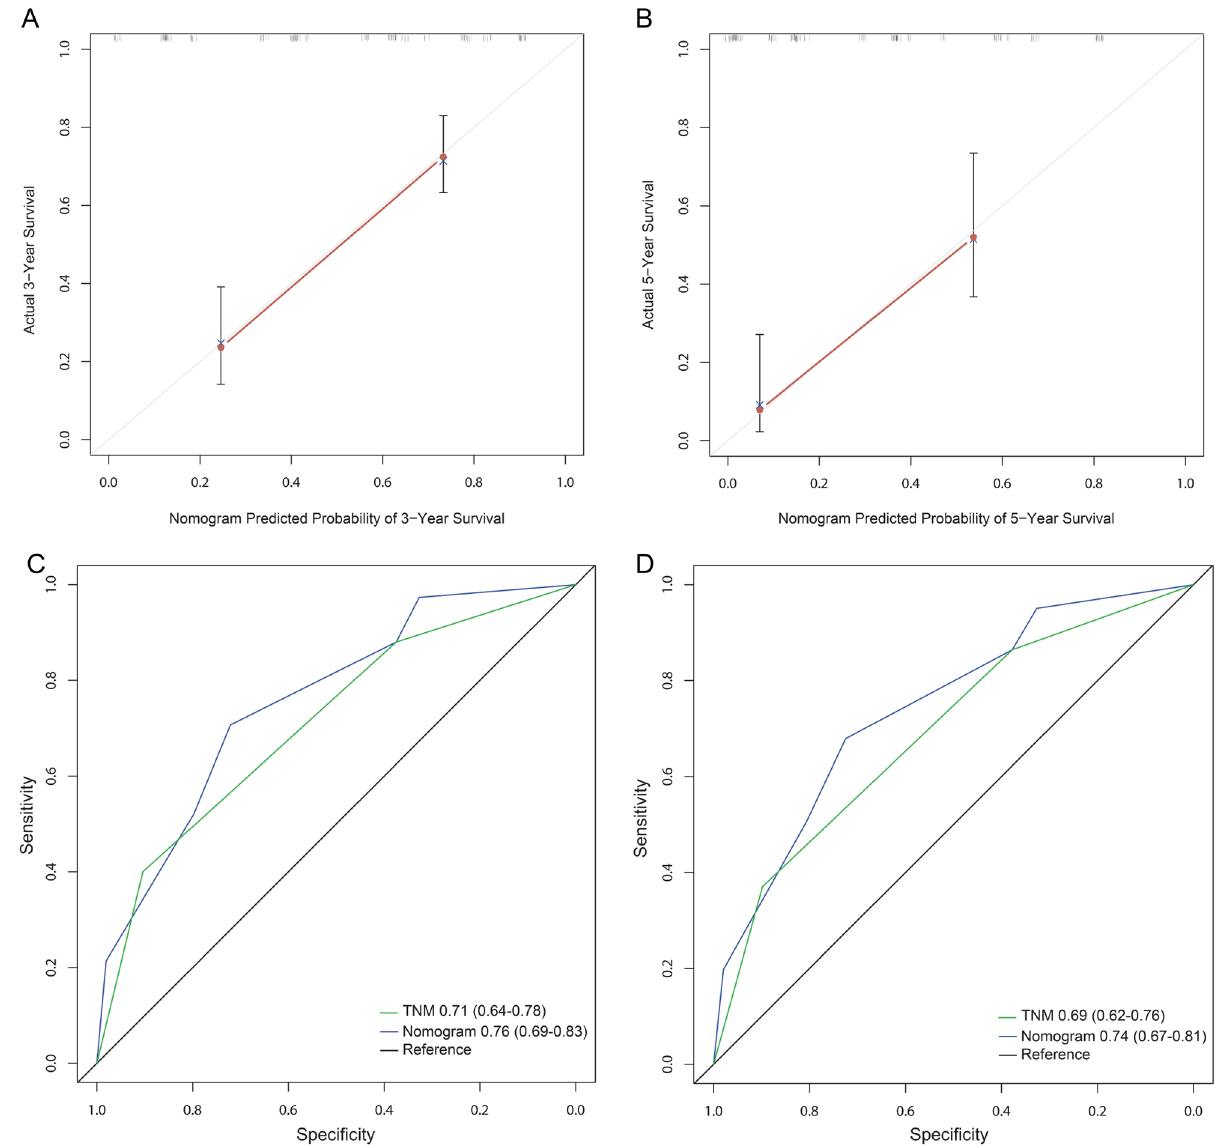
Figure 5. The 3-year ( A ) or 5-year ( B ) survival rate of resectable gastric cancer patients predicted by nomogram is highly consistent with the actual observed values in the validation cohort. The ability of ROC analysis nomogram to predict the 3-year ( C ) or 5-year ( D ) survival rate of resectable gastric cancer patients, the nomogram has a larger AUC than TNM staging in the validation